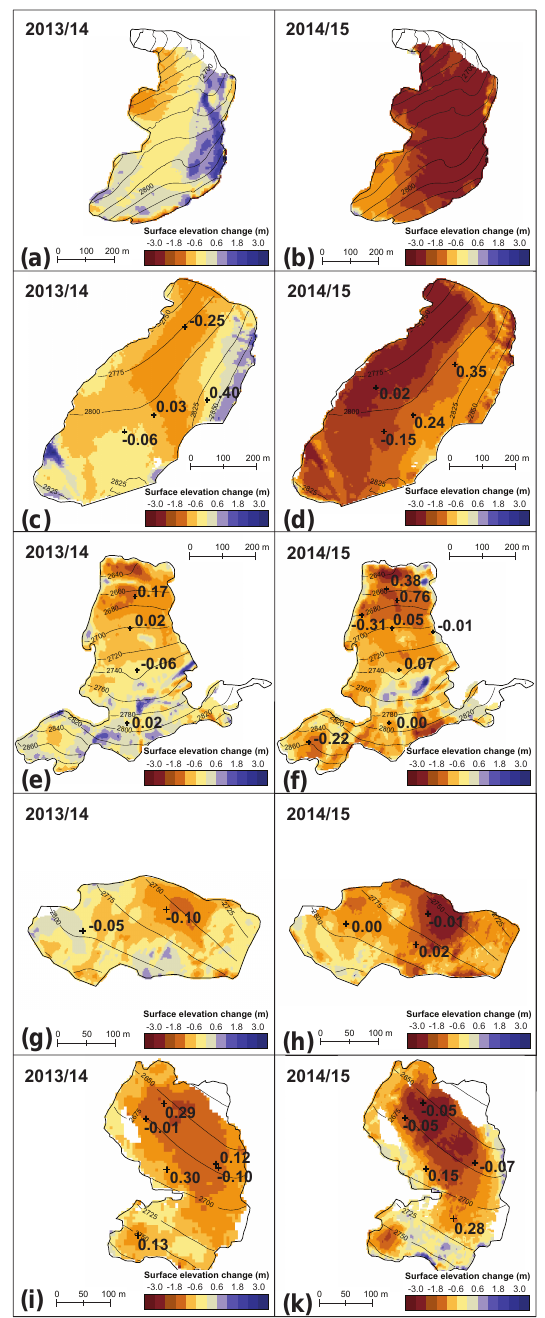
Figure 4. Spatial distribution of TLS-derived annual surface eleva- tion changes (cid:49)h TLS for (a, b) Glacier de Prapio, (c, d) Glacier du Sex Rouge, (e, f) St. Annafirn, (g, h) Schwarzbachfirn, and (i, k) Pi- zolgletscher in 2013/14 and 2014/15. The numbers indicate the dif- ferences (in m) between TLS-derived and in situ measured annual elevation changes at ablation stakes ( (cid:49)h TLS minus (cid:49)h direct ). White areas correspond to lidar